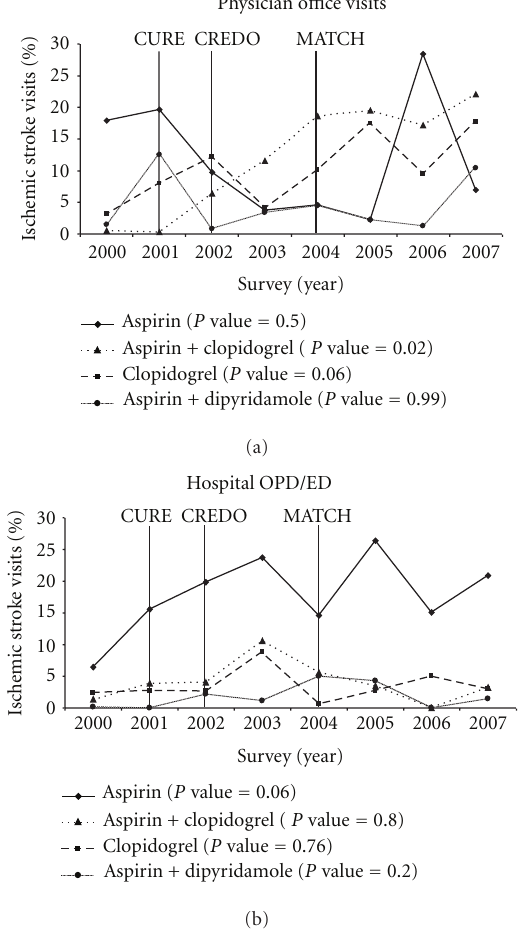
Figure 2: Antiplatelet prescribing trends among patients with ischemic stroke, by visit setting: 2000–2007. Physician o ffi ce visits based on National Ambulatory Medical Care Survey data; Hospital ED/OPD visits based on National Hospital Ambulatory Medical Care Survey data; OPD: Outpatient Department; ED: Emergency Department; P values based on Cochran-Mantel-Haenszel test for trend. Years of publication of the 3 clinical trials shown in the figure above: 2001—CURE (Clopidogrel in Unstable Angina to Prevent Recurrent Events trial); 2002—CREDO (Clopidogrel for the Reduction of Events During Observation); 2004—MATCH (Management of ATherothrombosis with Clopidogrel in High-risk